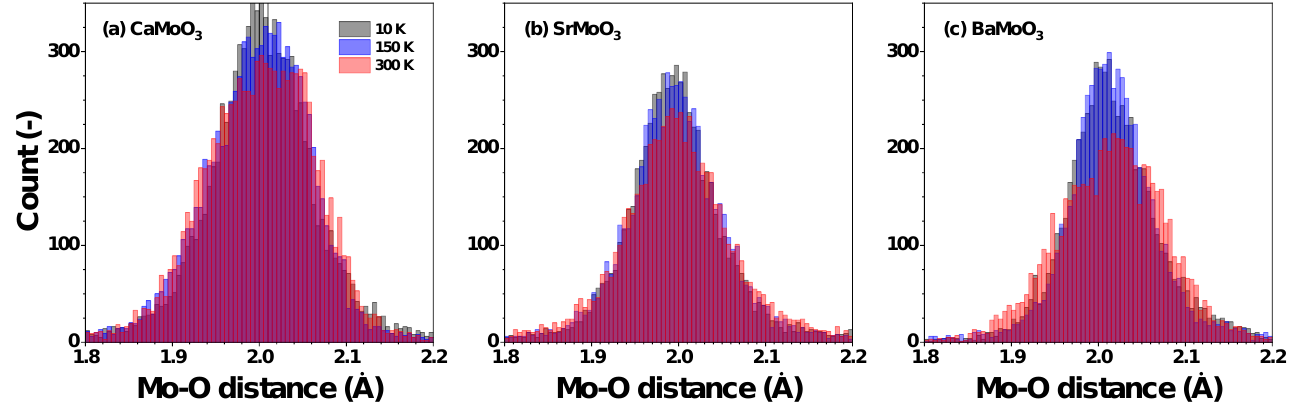
Figure 5. Histograms of the Mo–O distances—cf. radial distribution functions (RDFs) g Mo–O ( r ) — in polycrystalline ( a ) CaMoO 3 , ( b ) SrMoO 3 , and ( c ) BaMoO 3 at 10 K, 150 K, and 300 K. See text for